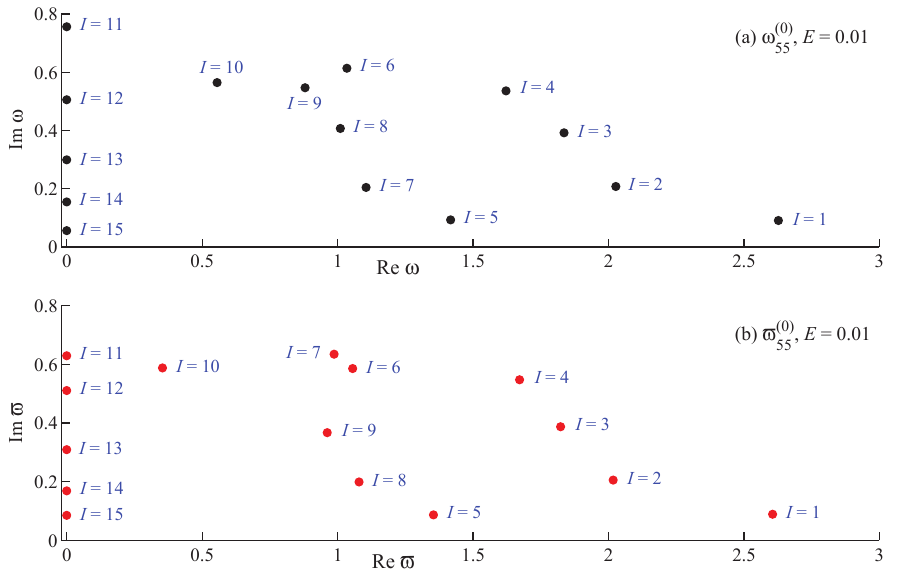
( 0 ) ( 0 ) and ( b ) ω . Here, the numbering with respect 55 55